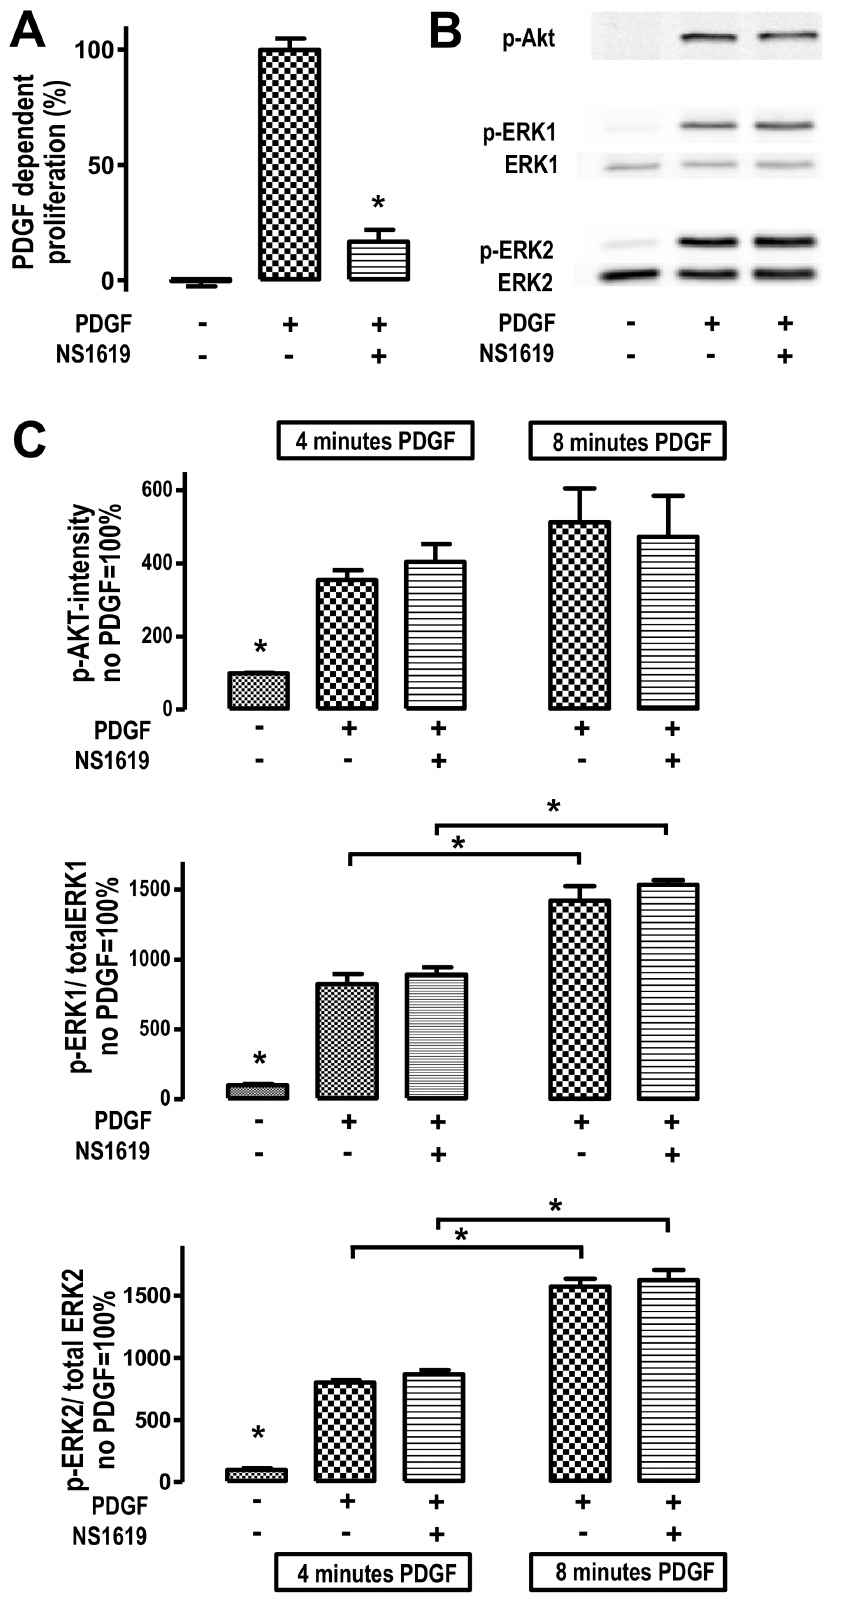
Figure 3. NS1619 attenuates PDGF-induced PASMC proliferation. (A) BK channel opening agent NS1619 (100 m mol/l) reduces PDGF-induced PASMC proliferation (n=21 each column; * p , 0.05). (B,C) In cultured PASMCs, phosphorylation state of protein kinases ERK1, ERK2 and AKT increased